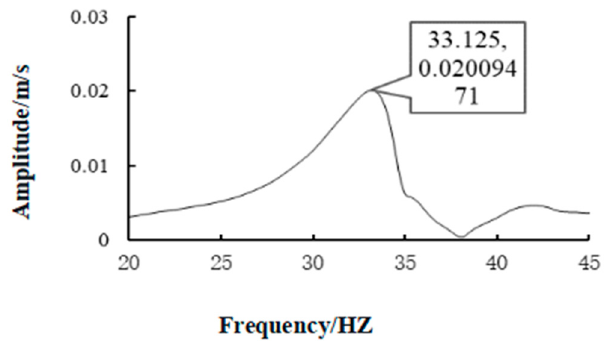
Figure 4. Vibration frequency-domain diagram.